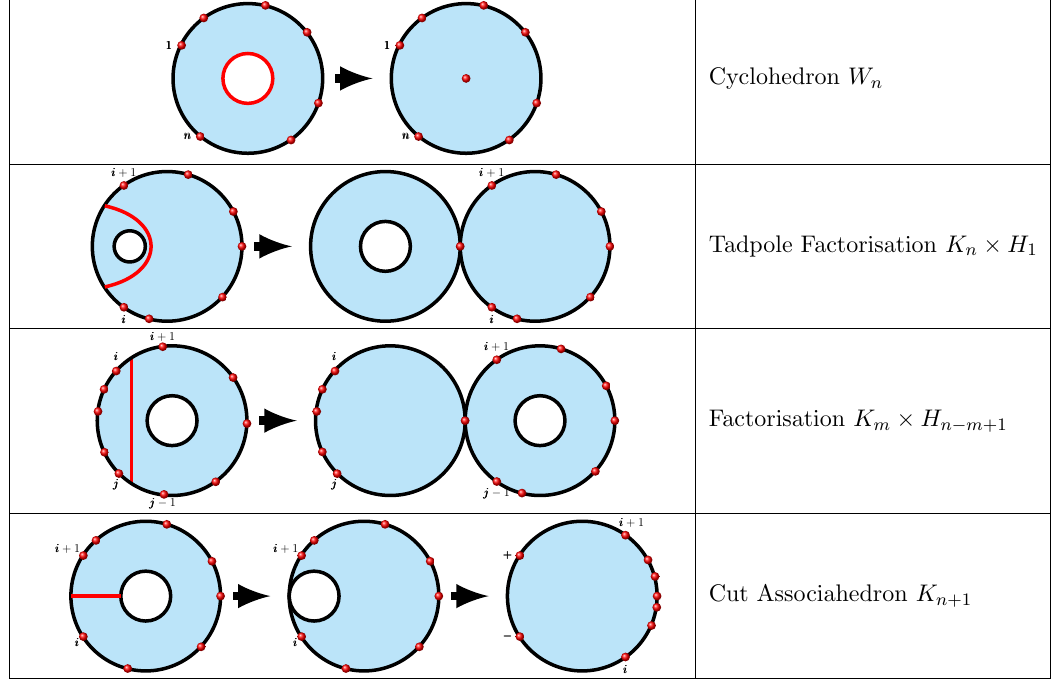
Table 2 . Realisation of di(cid:11)erent faces of H n .